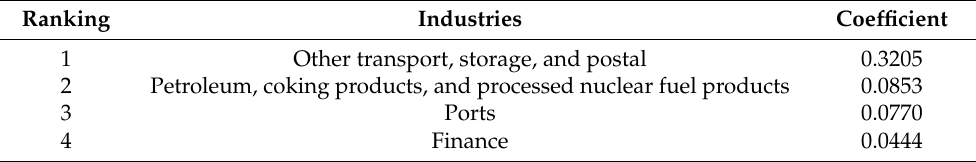
Table 2. Complete consuming coefficients for the port industry of Xiamen in 2017.